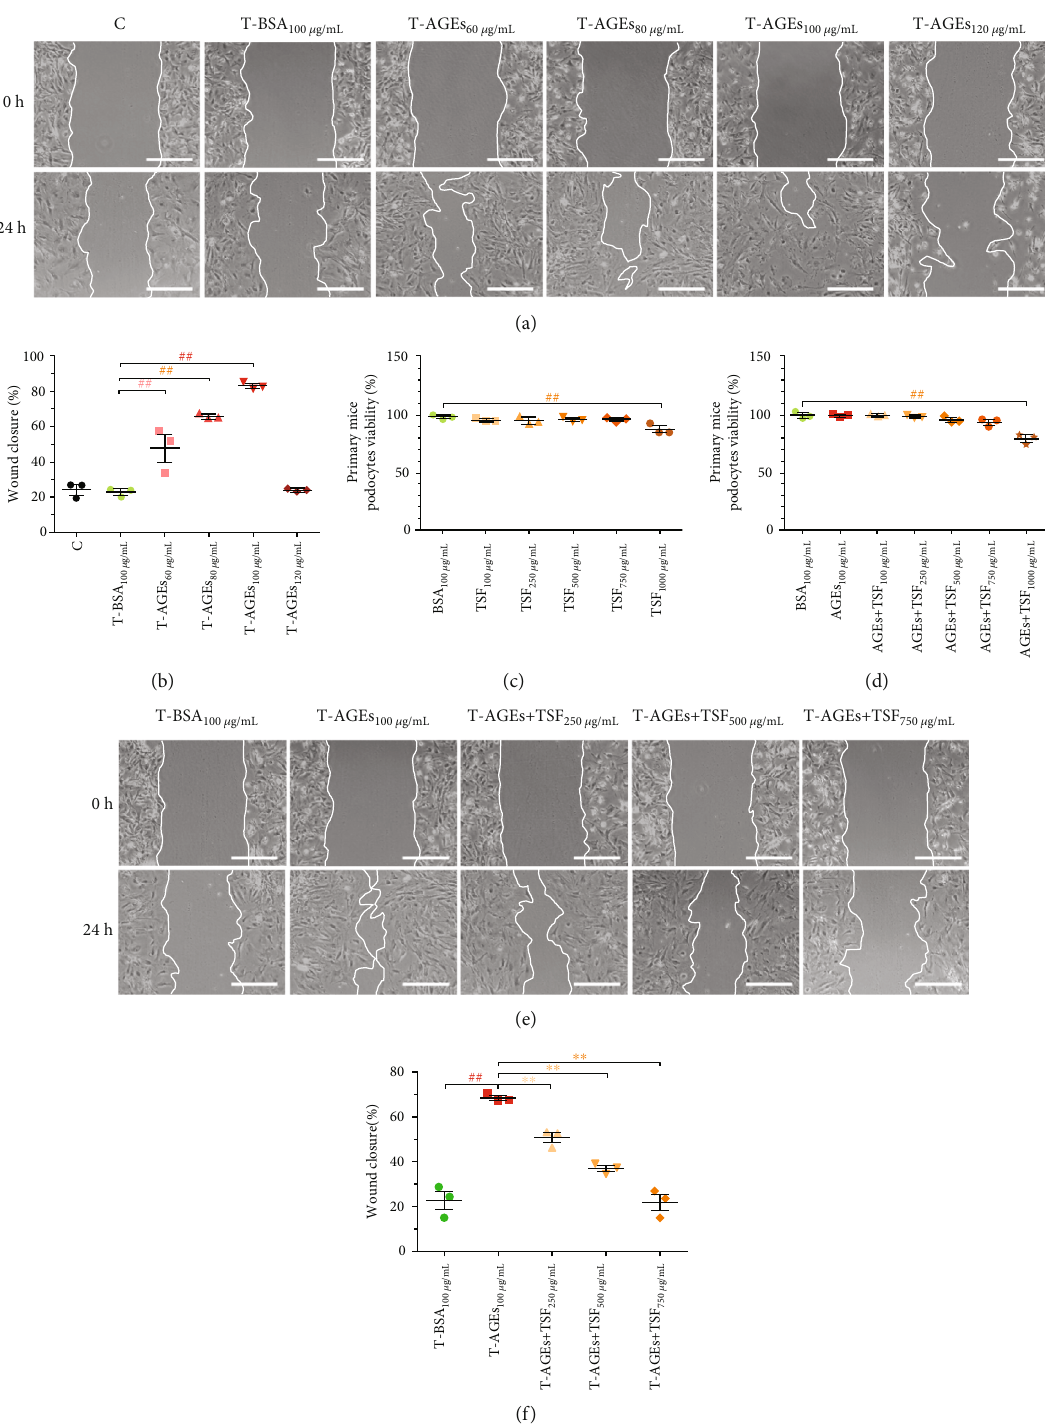
Figure 4: TSF attenuated the increased cell migration in AGEs-stimulated primary mice podocytes. (a, b) Wound healing assay and quantitative analysis using di ff erent doses of AGEs for 24 hours to observe the e ff ect on primary mice podocytes (scale bars, 100 μ m) ( n = 3 experiments). (c, d) Viability of primary mice podocytes was determined with MTT assay ( n = 3 experiments). (e, f) Wound healing assay and quantitative analysis using di ff erent doses of TSF for 24 hours (scale bars, 100 μ m) ( n = 3 experiments). The data were expressed as the mean ± SEM of three independent experiments performed in triplicate. # P < 0 : 05 , ## P < 0 : 01 vs. BSA group; ∗ P < 0 : 05 , ∗∗ P < 0 : 01 vs. AGEs group. Statistically analyzed via a one-way ANOVA with Dunnett ’ s